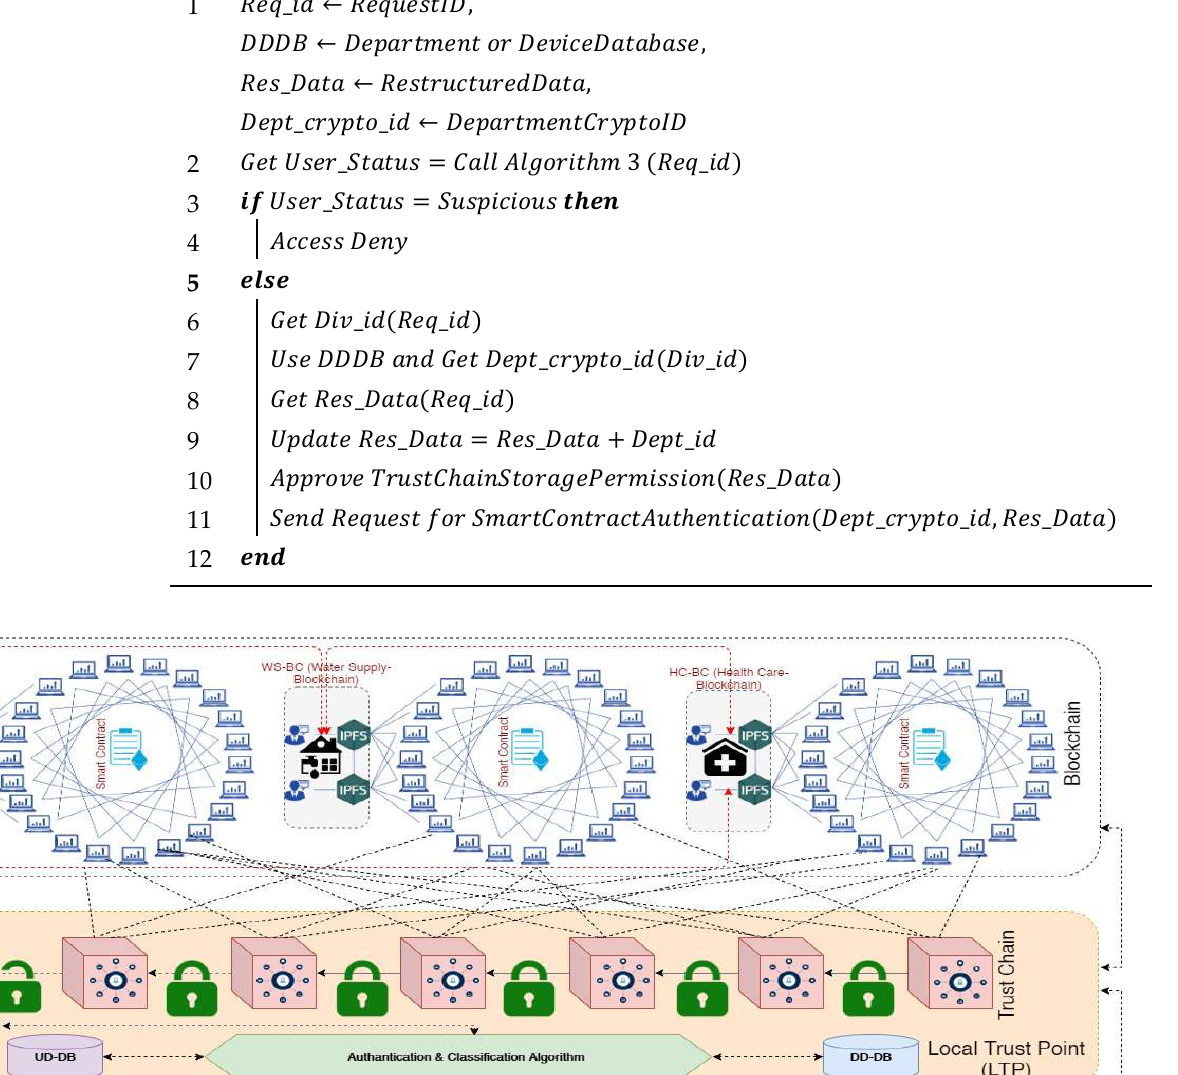
Algorithm 4: Local Trust Point (LTP) User Classification Algorithm.